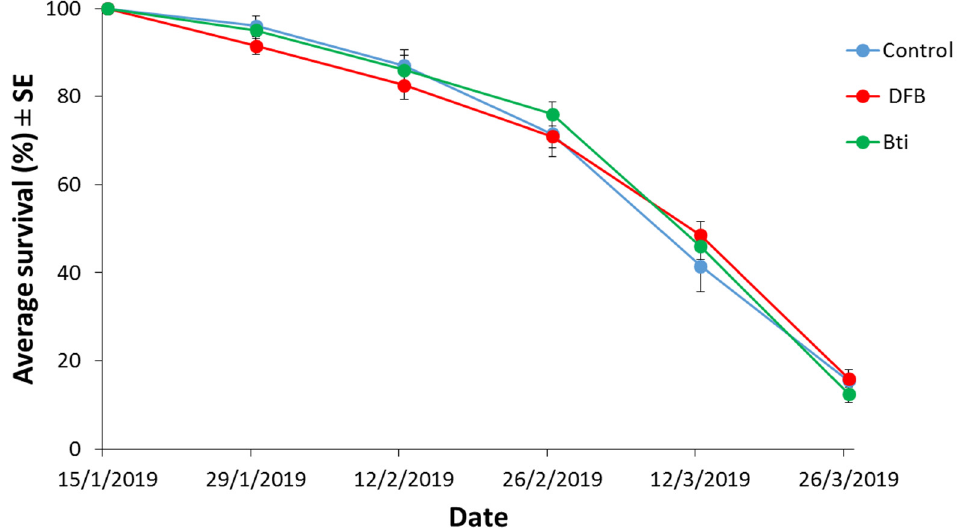
Figure 2. Winter survival rates of diapausing females of Cx . pipiens f. pipiens populations that were either selected against diflubenzuron (DFB) and Bti for three successive generations or not (control). For each population, five replicates were considered involving 40 females each. Table 5. Reproductive parameters of post-overwintering Cx. pipiens f. pipiens females. Females originated from popula- tions that were either selected against diflubenzuron (DFB) and Bti for three successive generations or not (control). In each column, different letters indicate significant differences ( p < 0.05).